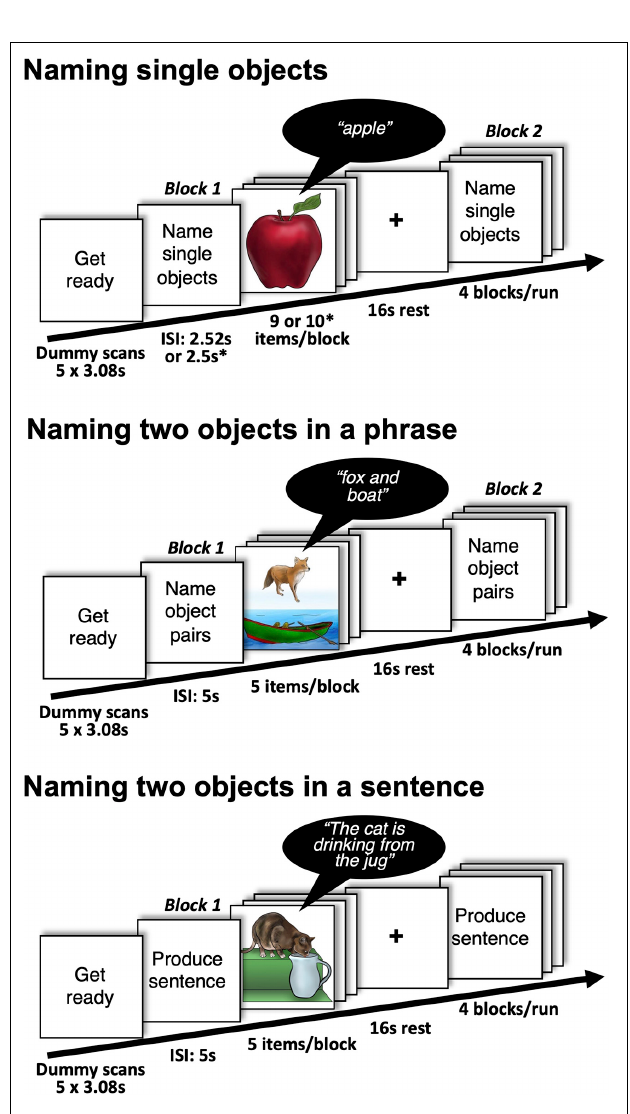
FIGURE 1 | Details of the experimental design with examples of stimuli and expected responses during naming single and two objects. Participants were also asked to perform a single auditory object naming task (naming objects from sounds). ∗ presentation parameters used in Group